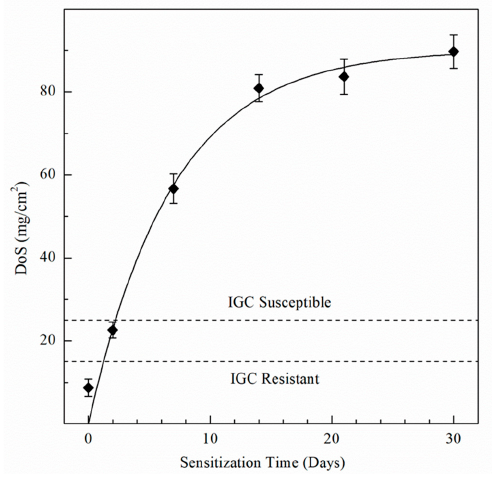
Figure 1. Degree of sensitization (DoS) values for AA5083 sensitized at 150 °C using the NAMLT test standard ASTM G67–18. Error bars represent the standard deviation from the mean. Table 2. Average values of DoS obtained by NAMLT test, as well as i corr , E corr , E pit , E ptp , C eff,f , d eff , C eff,int and C eff,dl values calculated from cyclic potentiodynamic polarization (CPP) and electrochemical impedance (EIS) data for sensitized AA5083 at 150 °C for specified times. Parentheses represent standard deviation.